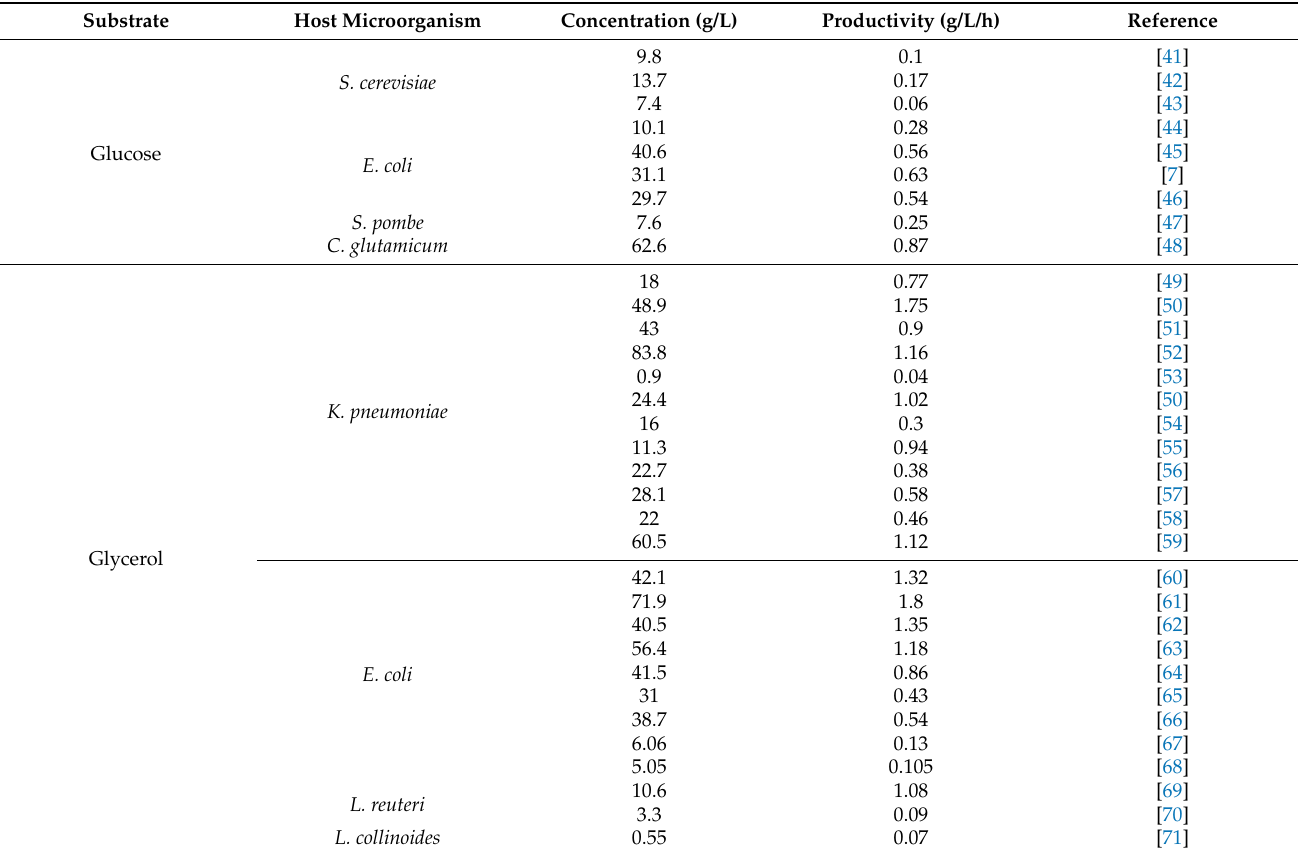
Figure 4. Structure of 3-hydroxypropionic acid (C 3 H 6 O 3 ). 3-HP can be produced via microbial fermentation pathways from two major substrates: glucose and glycerol [39]. Matsakas et al. [40] presented a comprehensive review on 3-HP production and its production pathway mechanisms. Table 3 provides an overview of how various microorganism compare in terms of their concentrations and productivity of 3-HP, with glycerol and glucose as the two main substrate sources. Table 3. 3-hydroxypropionic acid concentration and productivity based on various microbes and two main substrate sources, i.e., glucose and